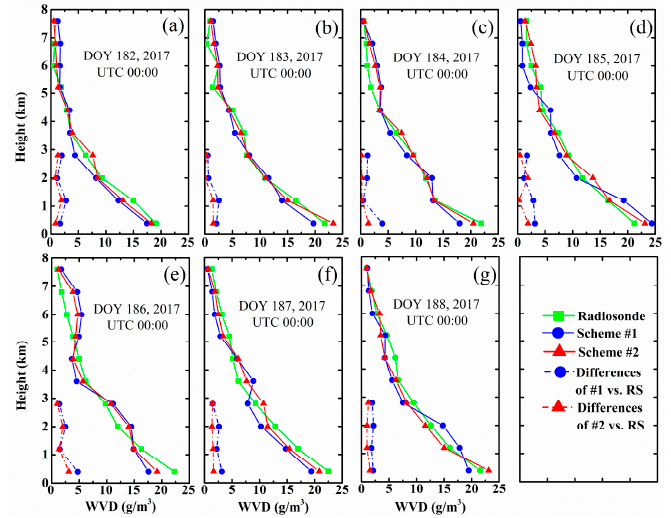
Figure 8. ( a – g ) represent water vapor density profile comparisons between radiosonde and different schemes at UTC 00:00 from DOY 182 to 188, 2017.